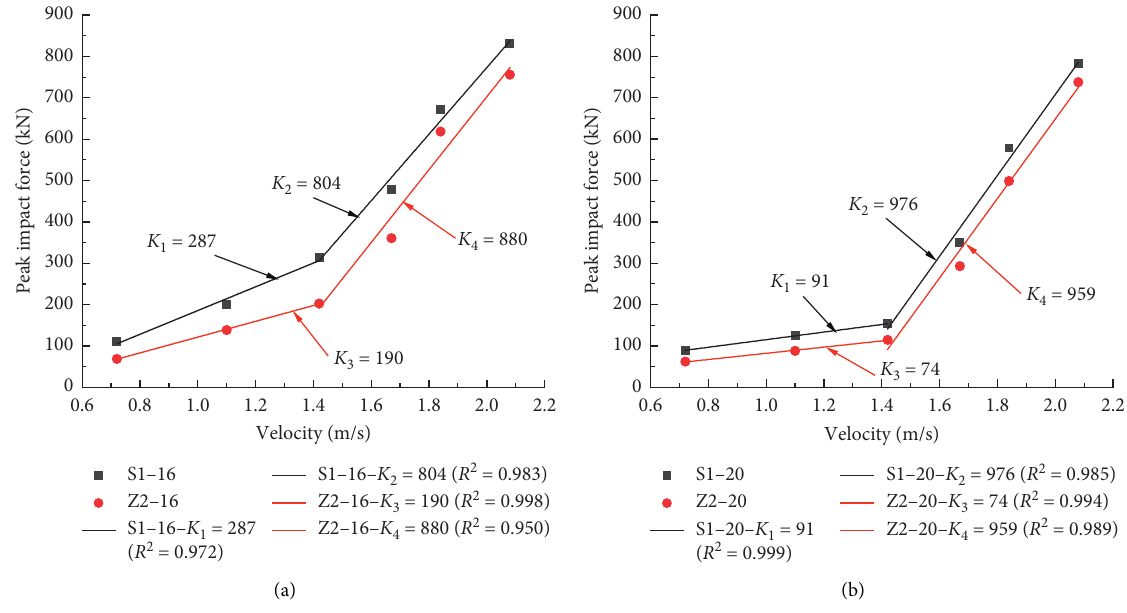
Figure 11: The peak value of the impact force of the first and second groups.